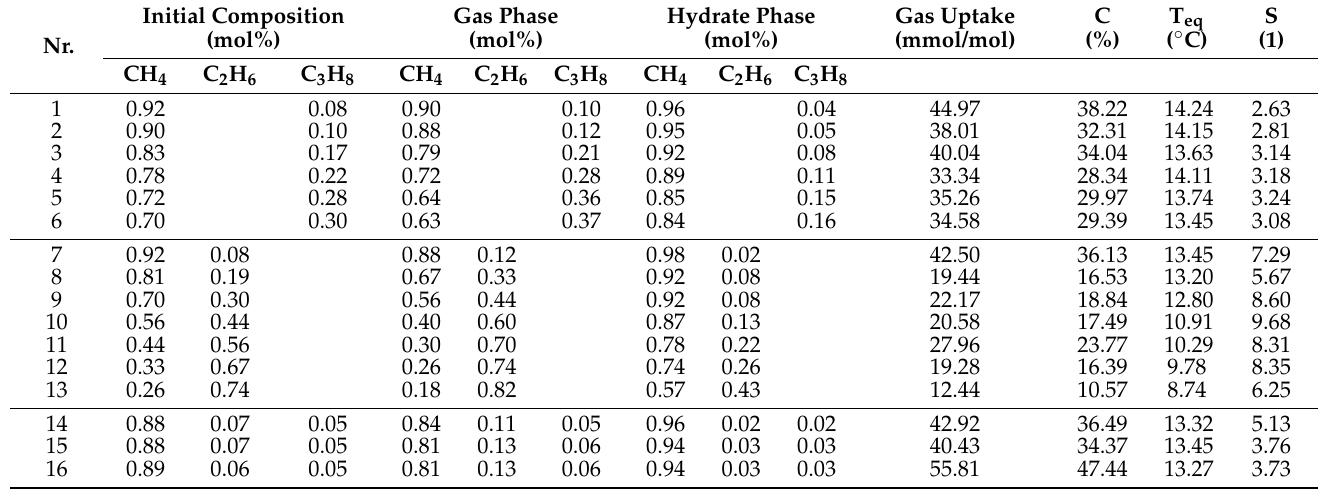
Table 2. Experimental results, equilibrium pressure 8